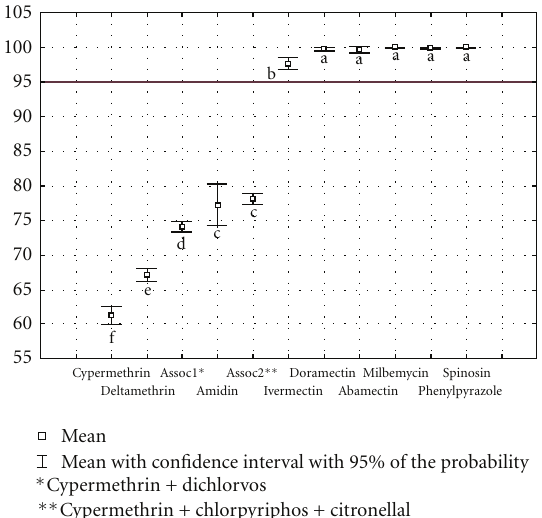
Figure 2: E ff ectiveness of acaricide bases observed in adult immer- sion test (AIT) in Rhipicephalus microplus populations surveyed in Rondˆonia state, Brazil. ∗ Means followed by the same letter do not di ff er according to the Tukey-Kramer test at 1% significance. The bar indicates the 95% minimum e ffi cacy set by Brazilian federal regulations for the marketing of acaricides.